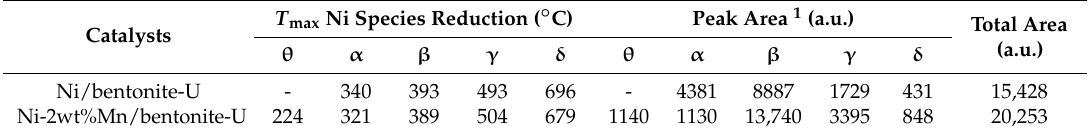
Table 3. Temperatures and area distributions of reduction peaks of Ni/Bentonite-U and Ni- 2wt%Mn/Bentonite-U catalysts.